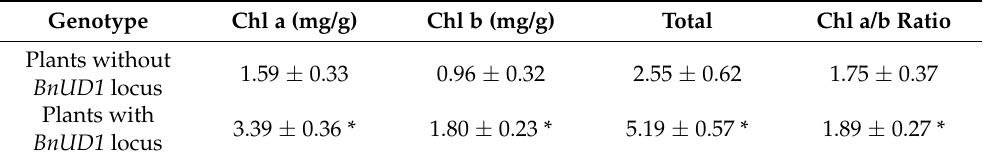
Table 4. Leaf chlorophyll contents in leaves of plants with BnUD1 locus and that without BnUD1 locus.